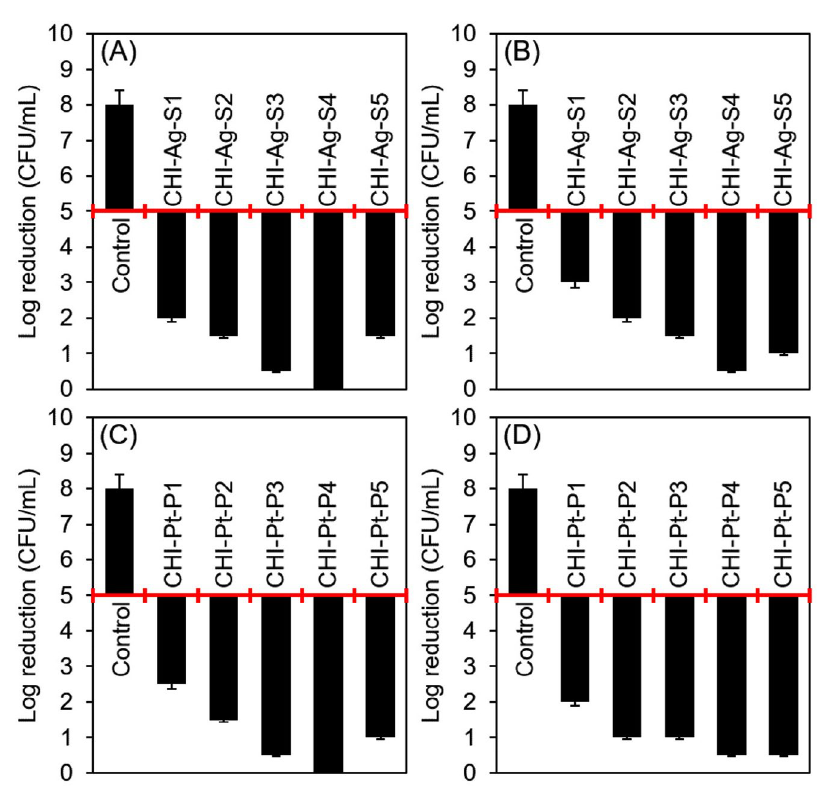
Fig. 11. Evaluation of the antibacterial activities of silver and platinum nanoparticles loaded chitosan-bio-composites. (A) and (B) are representing the antibacterial attributes of silver nanoparticles loaded bio-composites against B. subtilis , and E. coli , respectively. (C) and (D) are representing the antibacterial attributes of platinum nanoparticles loaded bio-composites against B. subtilis , and E. coli , respectively. The reduction in the initial bacterial count i.e. 1.5 × 10 8 CFU/mL showed bacteriostatic and bactericidal activities of the respective samples. A 2-log reduction was considered to claim an antibacterial